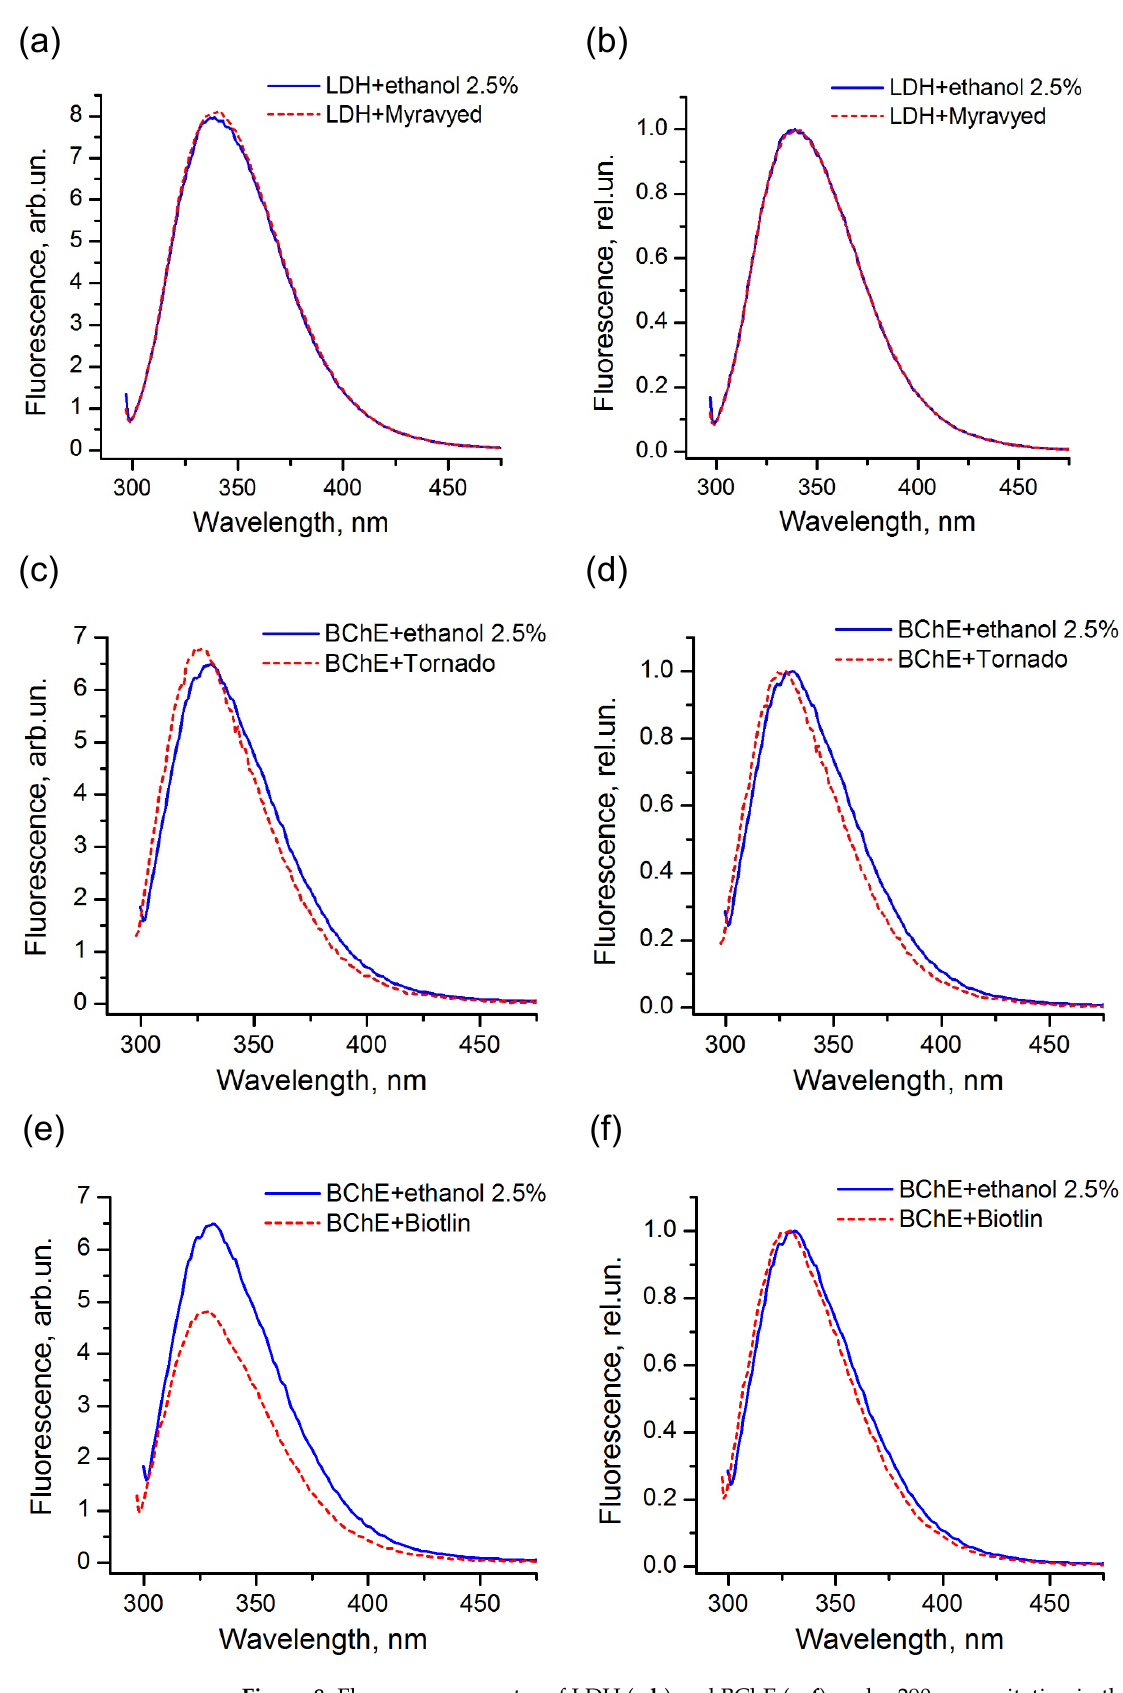
Figure 8. Fluorescence spectra of LDH ( a , b ) and BChE ( c – f ) under 290 nm excitation in the presence (dashed lines) and in the absence (solid lines) of commercial pesticide formulations Muravyed ( a , b ), Tornado Extra ( c , d ), and Biotlin ( e , f ). Normalized ( b , d , f ) and not normalized ( a , c , e ) spectra are shown. Protein concentrations were 0.4 mg/mL of LDH, 0.25 mg/mL of BChE. Concentrations of diazinon in Muravyed, glyphosate in Tornado Extra, and imidacloprid in Biotlin were 1.25 mg/L, 2.4 mg/mL, and 0.02 mg/mL, respectively. For LDH, no effect of Muravyed on protein fluorescence was observed. The components of Tornado Extra and Biotlin formulations cause the blue shift of the BChE fluorescence. For all proteins studied here, we observed the same profile of fluorescence spectra under 280 and 290 nm excitation, suggesting that tryptophan residues were the main flu- orescence emitters of the proteins. Thus, the fluorescence spectra and circular dichroism spectra obtained in the current study suggest that the effects of pesticide formulations on the tertiary and secondary structures of the majority of the proteins were insignificant. Thus, the inhibitory effect of commercial pesticide formulations demonstrated in the present study caused by different mechanisms such as the effect of pesticides on ligands (substrates of enzymes), disruption of the enzyme–substrate interaction (and, for multi-enzyme reactions, disruption of the interaction between enzymes in the conjugation chain) or some others. 3. Discussion Potential environmental hazards associated with the use of pesticides on the global scale is the reason for increased research effort in this area. More and more data have been gathered showing that toxicity of pesticide formulations is underestimated. The cumula- tive effect of various factors leads to considerable losses of pesticides in the environment, making it necessary to apply greater amounts of pesticides [4]. As pesticide components differ in chemical nature, they have dissimilar environmental fate [30]. Pesticides interact with both biotic and abiotic environmental factors. For example, UV radiation may change toxicity of pesticide formulations [31]. One of the most important factors, however, is that pesticide formulations are composed of various compounds. The active ingredients of pesticides have been specially developed to disturb the function of essential processes in target organisms (enzymatic reactions, mitochondrial respiratory chain, macromolecule biosynthesis, etc.) [31]. However, because of complexity and diversity of molecular processes, the side effects of pesticide formulations on non- target species may damage their enzyme systems, physiological mechanisms, or the bal-